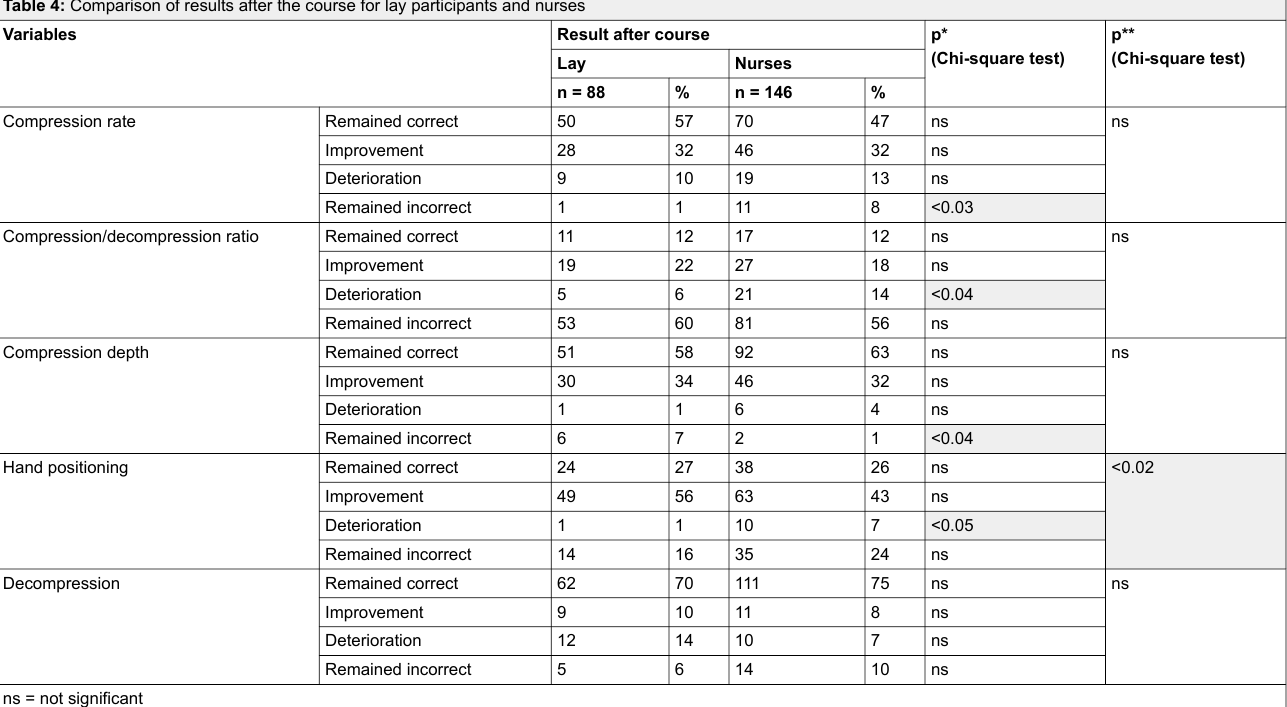
Table 4: Comparison of results after the course for lay participants and